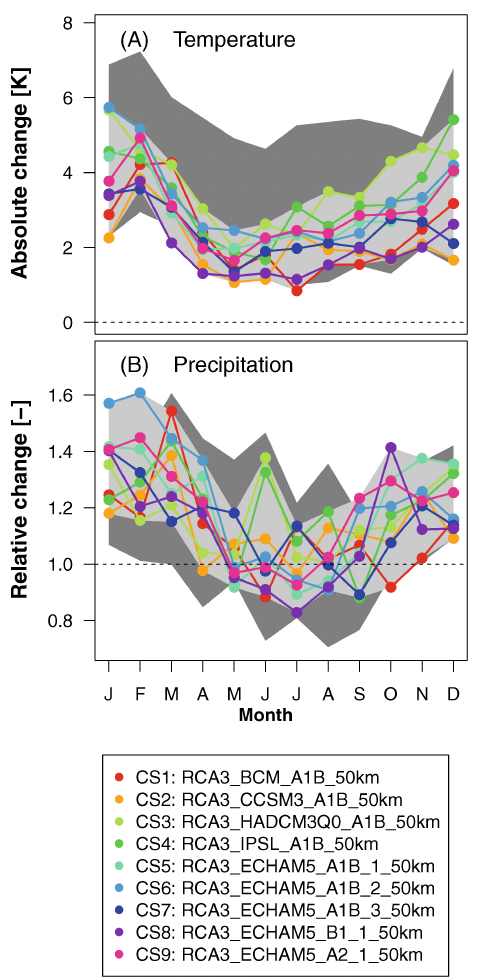
Fig. 1. Monthly change factors for (A) temperature and (B) pre- cipitation derived from the nine different climate scenarios (see Ta- ble 2). The dark-grey background area represents the spread in the change factors for southern Sweden derived from an ensemble of 23 different GCMs (taken from Lind and Kjellström, 2008).